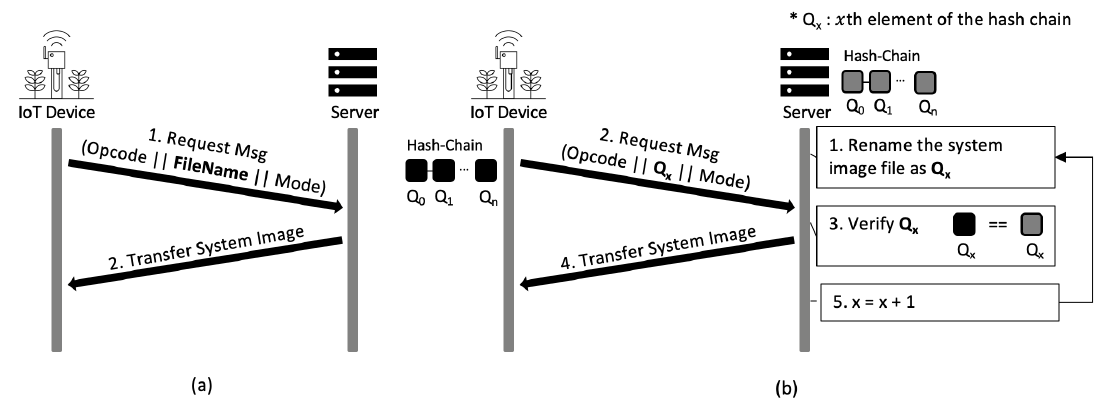
Figure 6. The procedure of TFTP-compatible file access control. ( a ) Flow chart of system image request and response on the native TFTP, ( b ) flow chart of the proposed TFTP-compatible file access